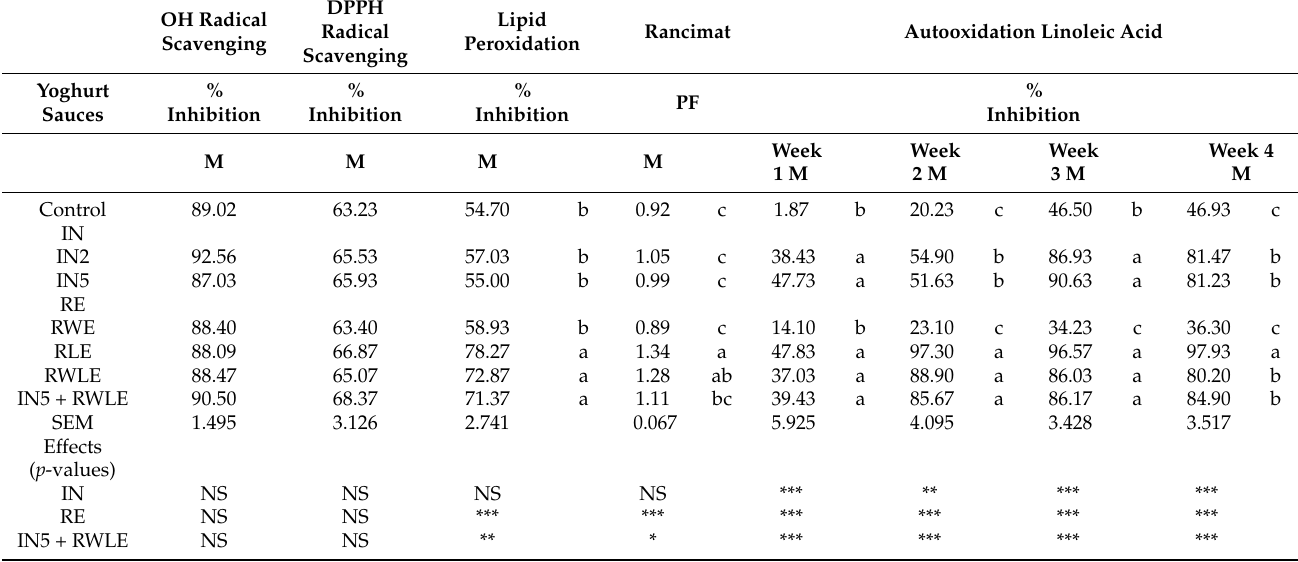
Table 5. Antioxidant activity evaluated by different assays (hydroxyl radical scavenging, DPPH, lipid peroxidation, Rancimat test and inhibition of autooxidation linoleic acid) in yoghurt sauces made with inulin and/or rosemary extracts.